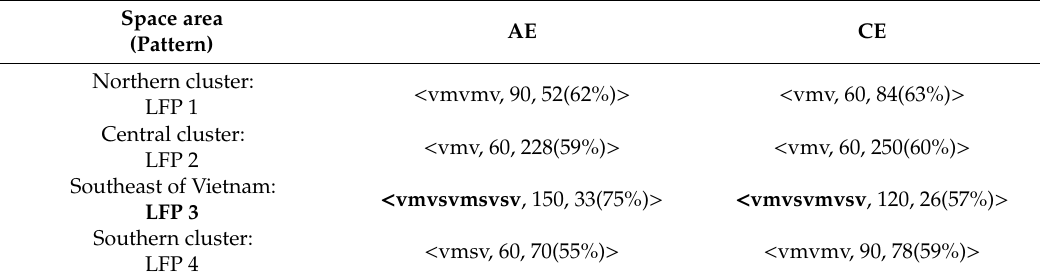
Table 1. The largest and most frequent patterns (LFPs) of the trajectory structures of AE and CE in the SCS.